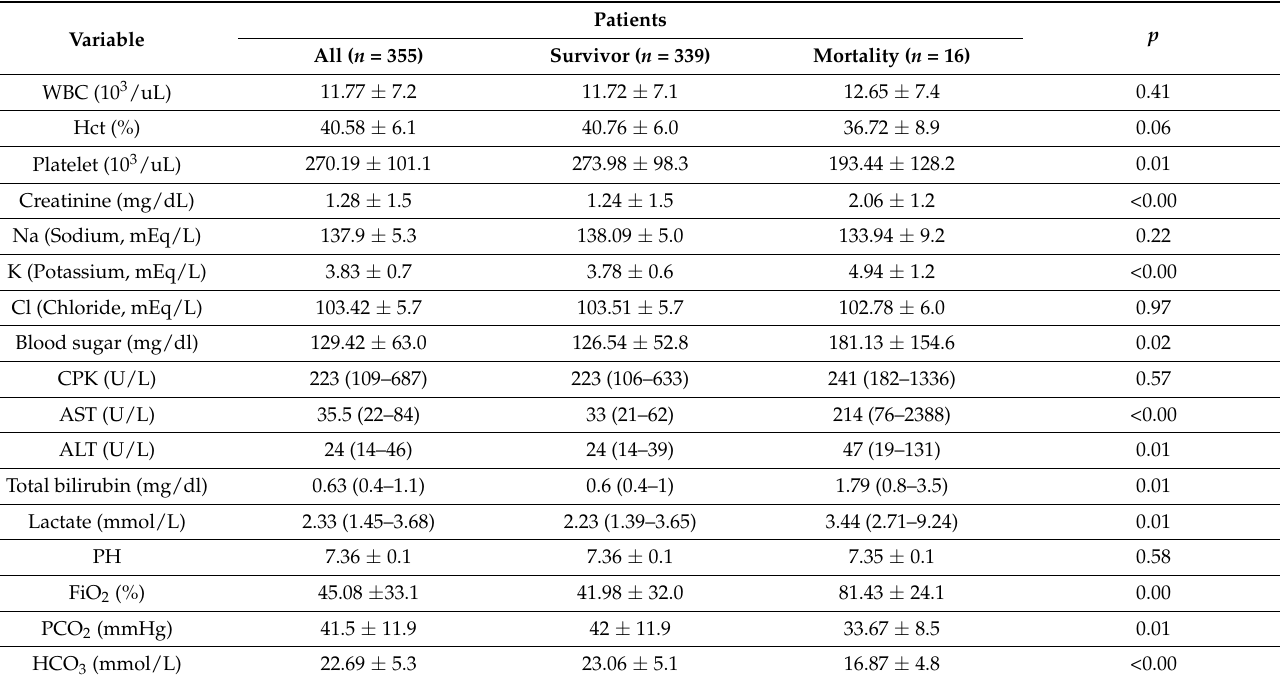
Table 4. Initial Laboratory data of the illicit drug users of survivors and mortality patients.